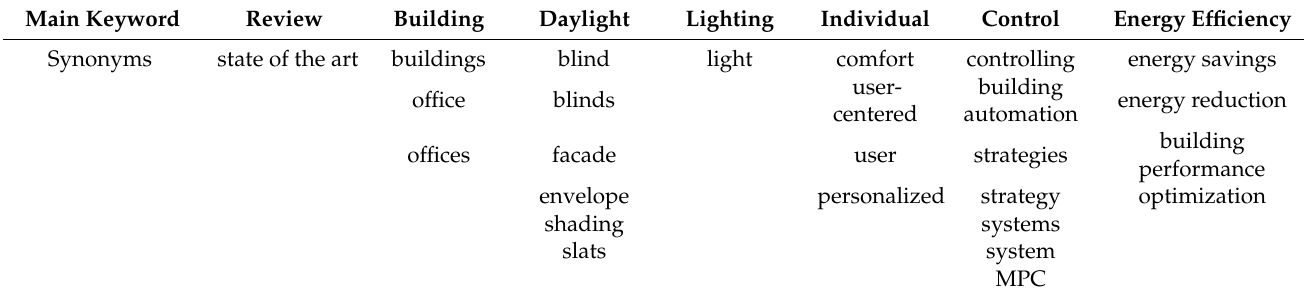
Table 1. List of main key words and corresponding synonyms as used in the literature search. Main